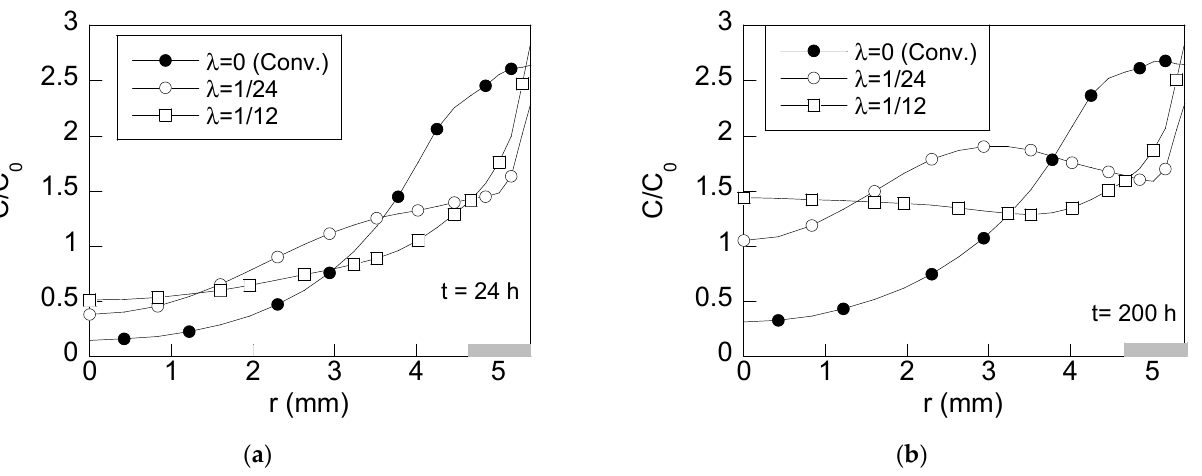
Figure 10. Radial distribution of hydrogen concentrations in cold drawn wires using conventional dies (filled circles) and non-conventional (innovative ) modified dies including a skin pass zone with optimal secondary reduction ratios (blank symbols): ( a ) after 24 h and ( b ) after 200 h of exposure to a hydrogenating environment.